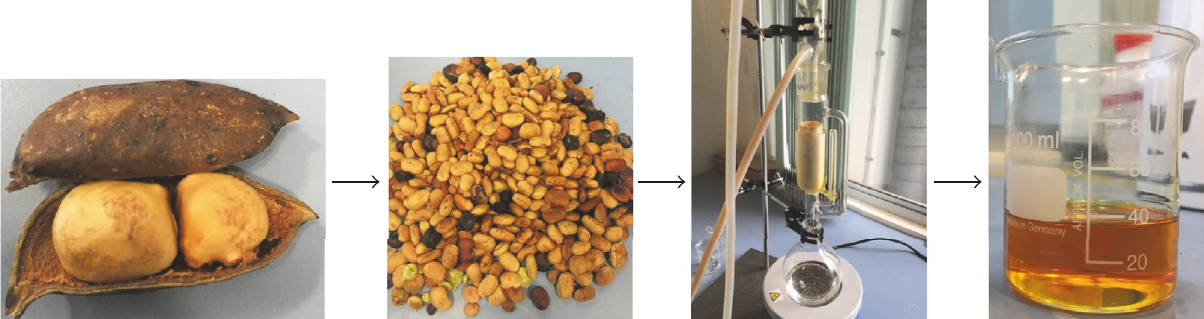
Figure 1: Crude karanja oil extraction process.